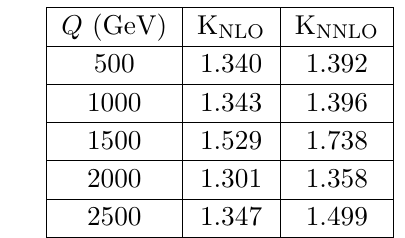
Table 1 . The (cid:12)xed order K-factors for the signal up to NNLO in QCD for 13 TeV